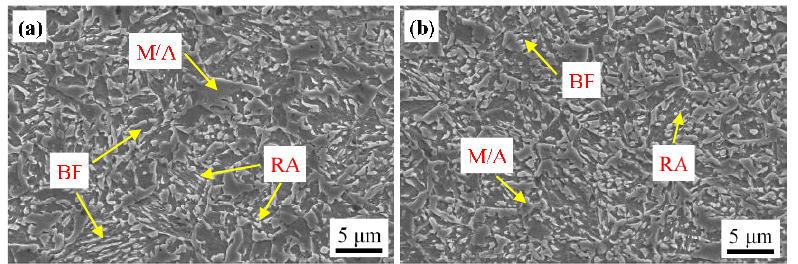
Figure 3. Microstructure of the samples CA400 ( a ) and SA400 ( b ). BF: bainitic ferrite; M/A: martensite austenite island; RA: retained austenite.